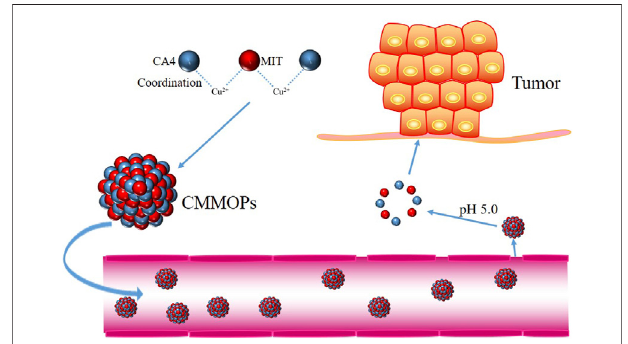
FIGURE 2 | (A) The schematic illustration of the coordination between Cu(II) and the drugs. The TEM image (B) , EDS elemental mapping (C – E) , and the EDS spectrum (F) of CMMOPs.